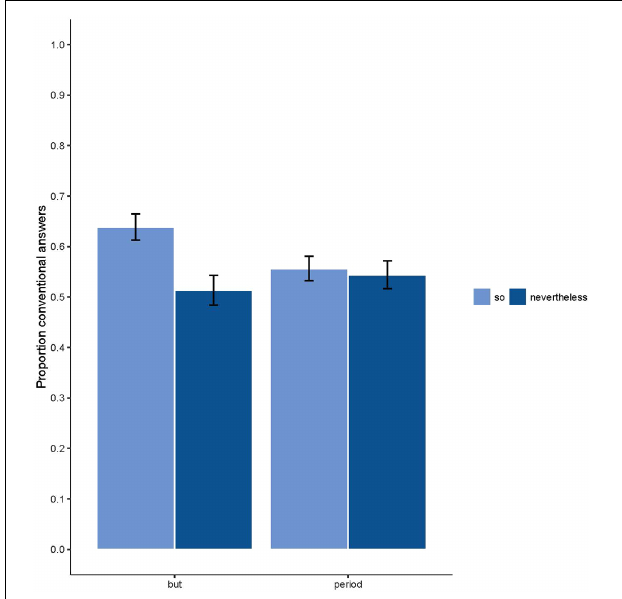
FIGURE 2 | Proportion of conventional answers as a function of connector ( but or period ) and conclusion type ( so or nevertheless ).